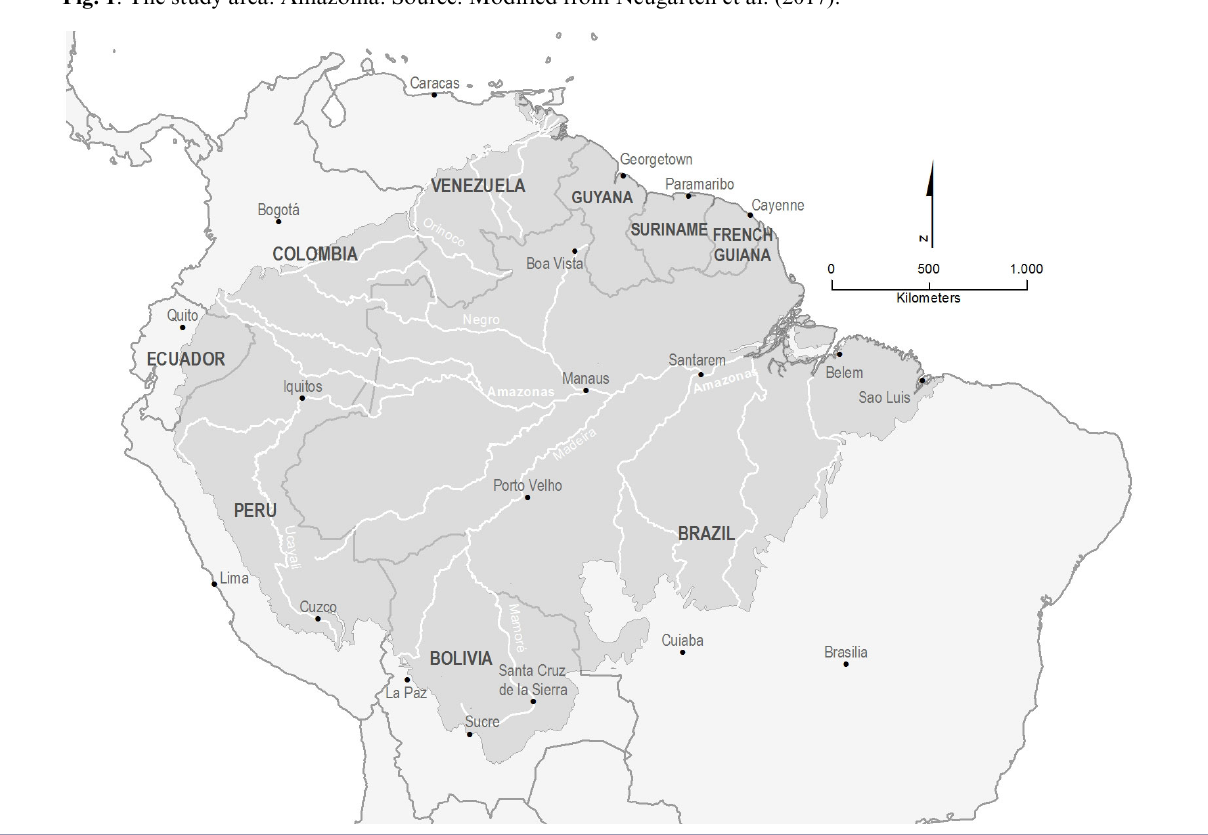
Fig. 1 . The study area: Amazonia. Source: Modified from Neugarten et al.